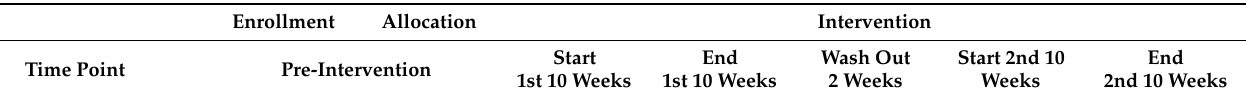
Table 2. Enrollment and data collection stratified by study time points (SPIRIT